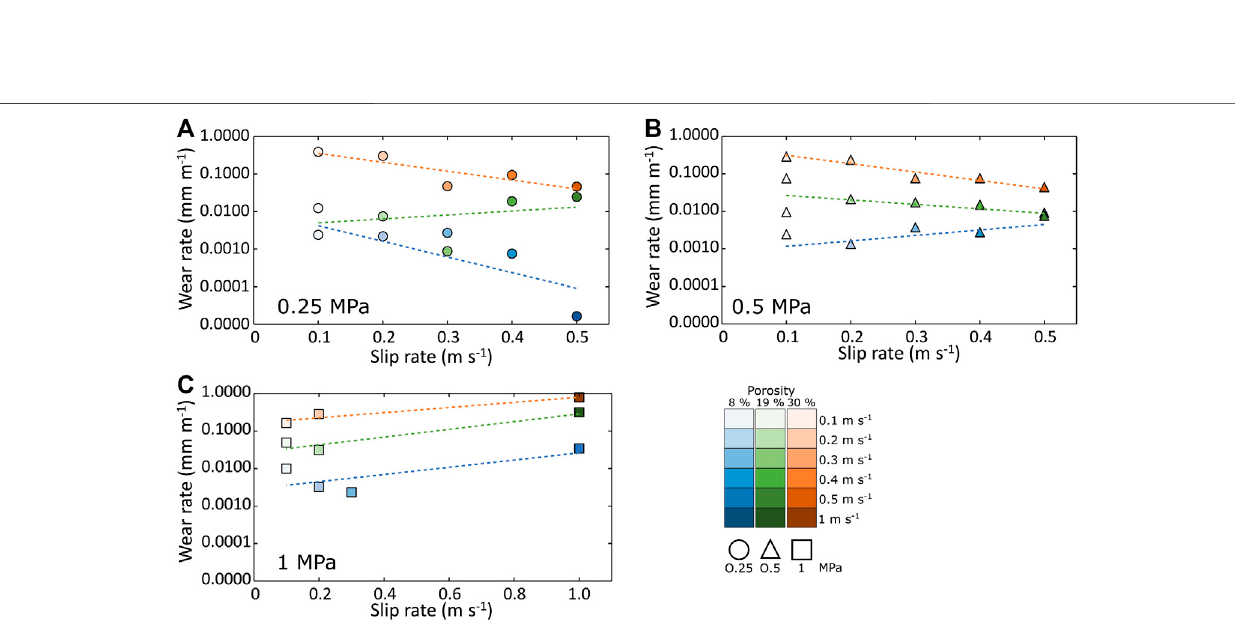
FIGURE 3 | Wear rate as a function of slip rate for samples of each porosity (8, 19 and 30%), at (A) 0.25 MPa, (B) 0.5 MPa and (C) 1.0 MPa normal stress. Wear ratesgenerallyincreasewithincreasingaxialloadandarehighestforthe30%,followedby19%and fi nally8%porositysamples.Atnormalstressesof0.25and0.5 MPa the 30% porosity samples show a reduction in wear rate with higher slip rates, with a reversed trend at 1.0 MPa. The 8 and 19% porosity exhibit negligible wear rates at 0.25 and 0.5 MPa ( Figure 1B ). The 1 m s − 1 test show much higher wear rates than low slip rate experiments. All wear rates have been corrected for thermal expansion using coef fi cient of expansion and thermal data recorded during